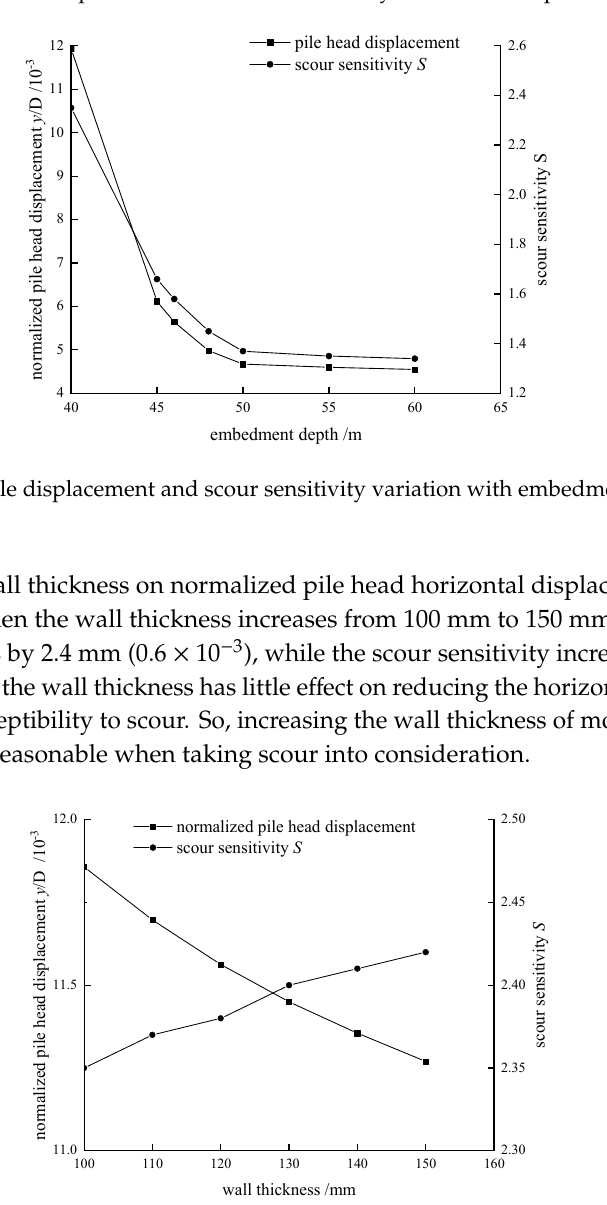
Figure 18. Variation of pile head displacement and scour sensitivity with pile wall thickness.